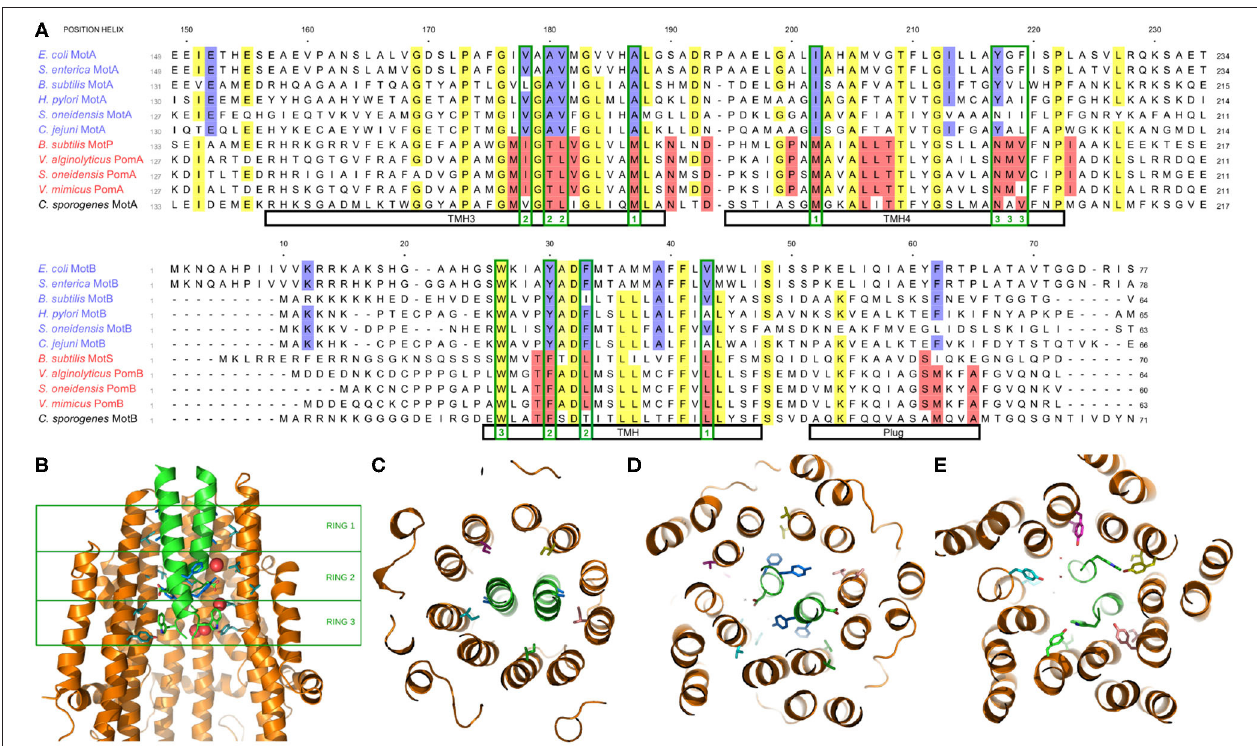
FIGURE 3 | (A) Multiple species sequence alignment of the A and B stator subunits. Highlighting denotes > 70% conservation across either all species (yellow) or differentially across only the H + or Na + stators (blue and red, respectively; the coupling ion of C. sporogenes remains unclear). Residues mentioned in the text which map to one of the three rings of differentially conserved residues are outlined in green with the corresponding ring noted at the bottom. (B) Side view of the stator, showing the two MotB and three of the five MotA (side chains shown for MotB and two MotA units). The three rings of differentially conserved residues are marked by the green boxes. (C) Bottom view (looking from the cytoplasm) of Ring 1. (D) Bottom view of Ring 2. (E) Bottom view of Ring